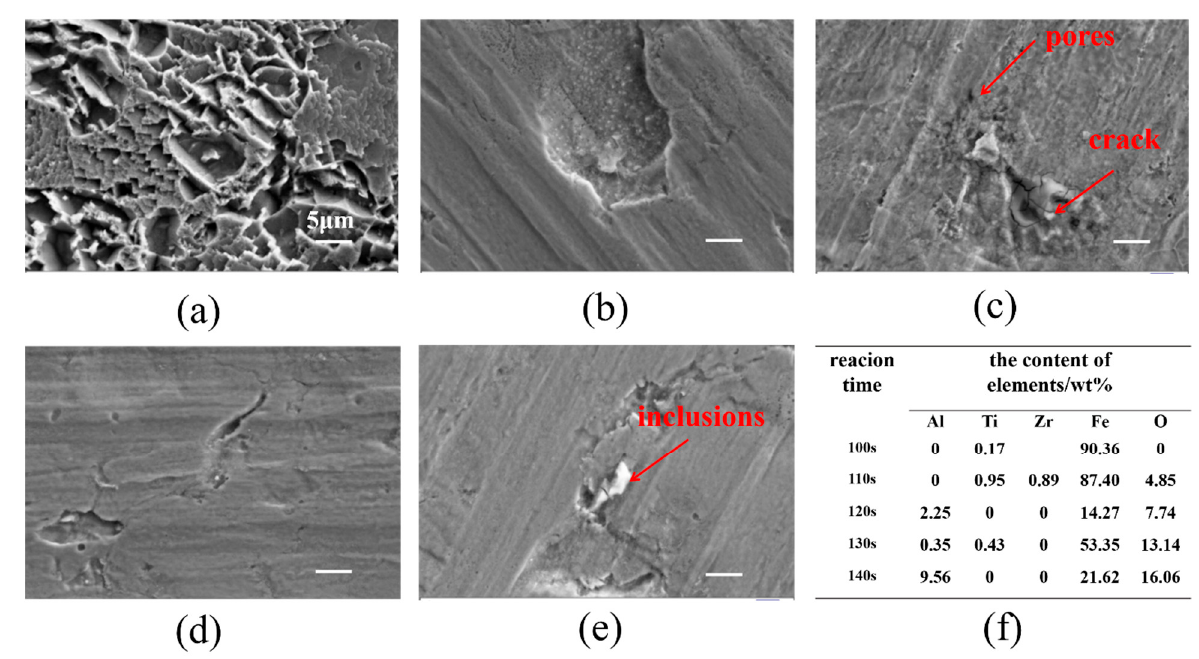
Figure 6. Results of SEM and EDS of galvanized steel with synchronous chemical conversion at different times: ( a ) at 100 s, ( b ) at 110 s, ( c ) at 120 s, ( d ) at 130 s, ( e ) at 140 s, ( f ) the EDS result of the conversion coating.